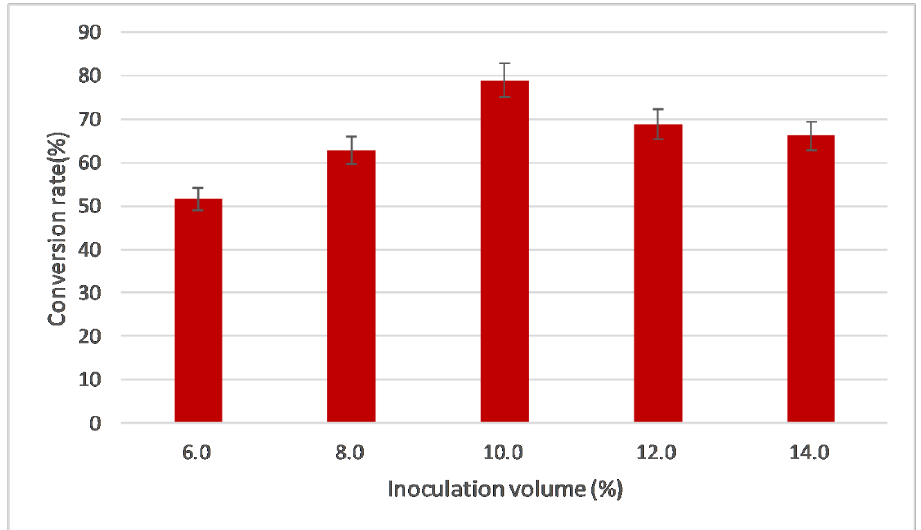
Figure 7. Effects of inoculation volume on metabolite conversion rate (initial pH = 6.5, culture time 5 d, media volume 50 mL, substrate concentration 1 mg/mL).